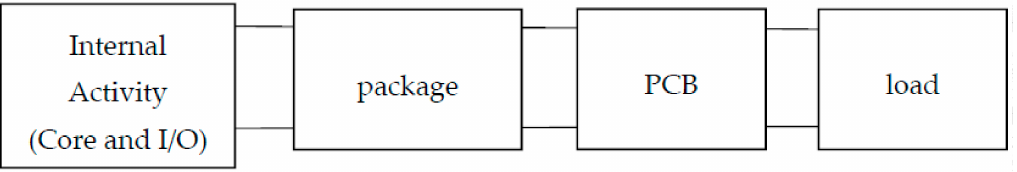
Figure 1. The conceptual scheme of the proposed circuit model, with the IC, the package, the PCB, and the final load.